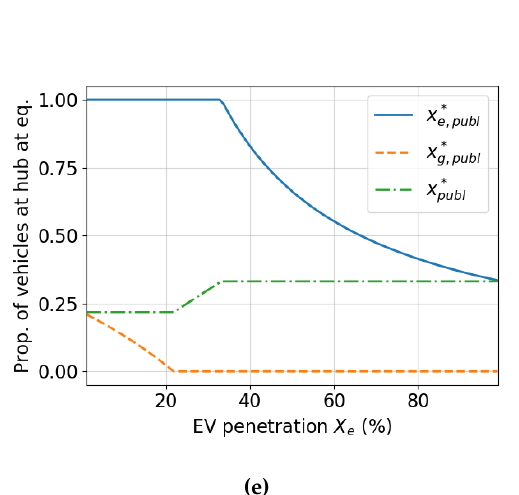
Figure 7. Proportion of vehicles at the hub at WE in function of...( a ) PT ticket fare t publ ; ( b ) value of time on the road τ priv ; ( c ) unit consumption of EV m e ; ( d ) unit consumption of GV m g ; ( e ) penetration of EV X e